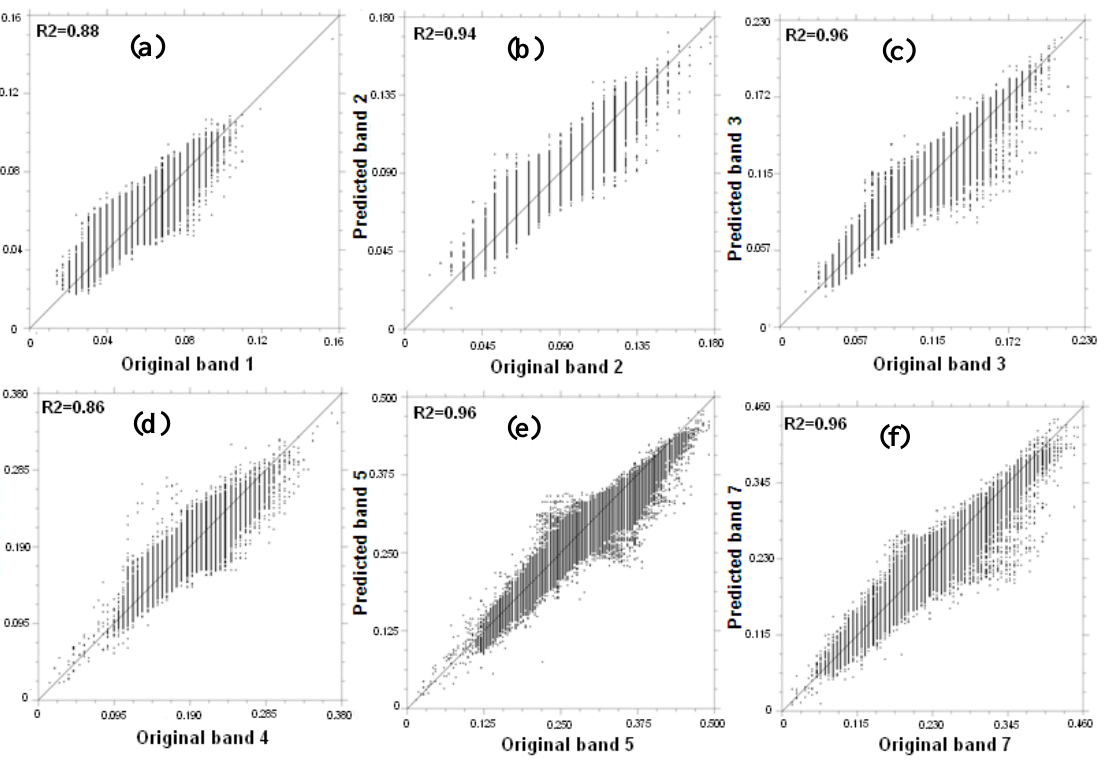
Figure 4. Per-pixel Comparison of reflectance in original and Spatial and Temporal Adaptive Reflectance Fusion Model (STARFM) predicted image of 2006/06/25 for Landsat TM bands 1-5, and 7 ( a – f ). All pixels of the subset image covering the study were